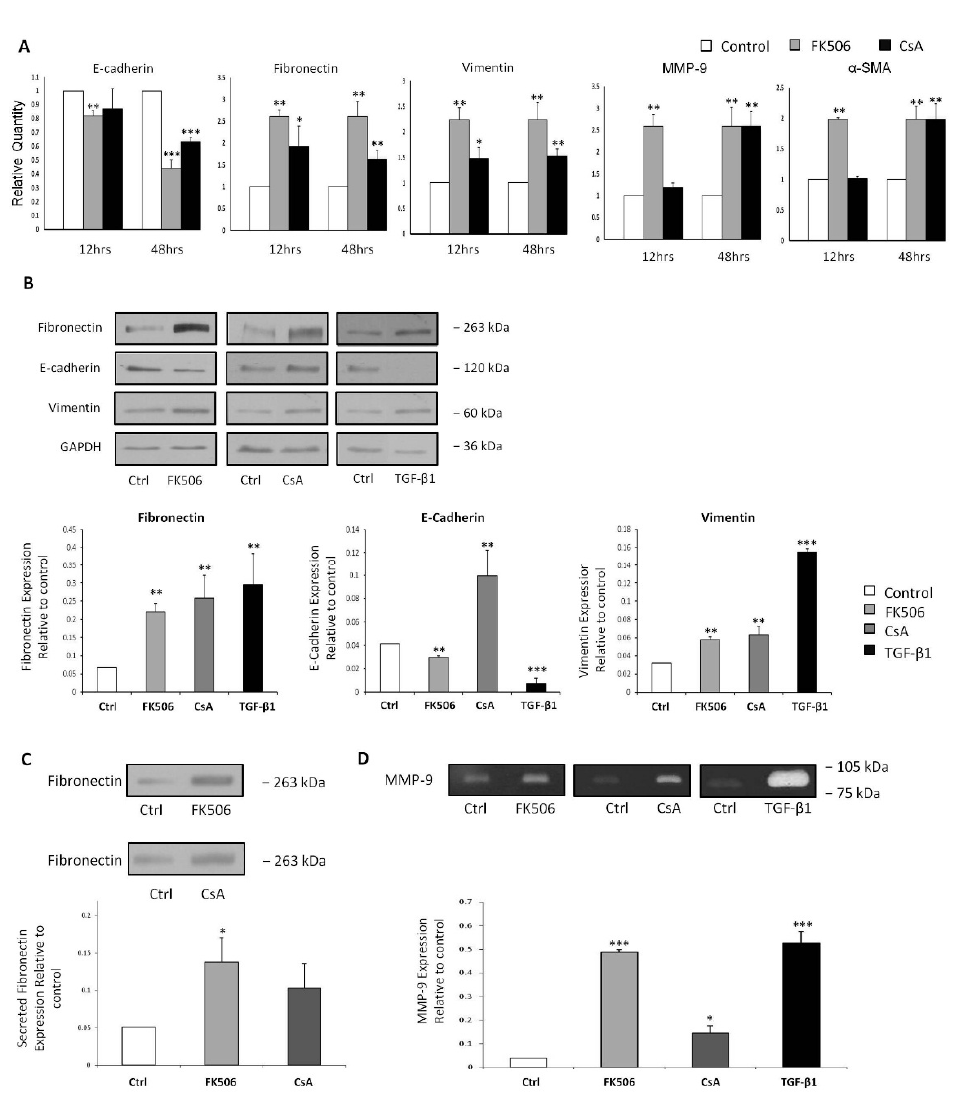
Figure 3. The effect of FK506 treatment on classical EMT markers. HK ‐ 2 RPTECs were cultured in 6 ‐ well plates and treated with control medium or medium containing 5 μ M FK506 or 5 μ M CsA for the indicated time periods. ( A ) RNA was isolated and cDNA synthesised. Real time RT ‐ PCR was then carried out on the cDNA using primers specific to E ‐ cadherin, fibronectin, vimentin, MMP ‐ 9 and α‐ SMA. 18S RNA was used as a total RNA control throughout. Data is expressed as a % change in mRNA levels relative to time ‐ matched control ± SEM ( n = 4): * p < 0.05, ** p < 0.01 vs. time ‐ matched vehicle treated control cells; ( B ) HK ‐ 2 cells were cultured on 6 ‐ well plates and treated with 5 μ M FK506, 5 μ M CsA or 5 ng/mL TGF ‐β 1 for 48 h and whole cell lysates were prepared. Equal amounts of protein were separated by SDS ‐ PAGE electrophoresis, transferred to nitrocellulose and indirectly probed for fibronectin, E ‐ cadherin and vimentin. GAPDH was used as a loading control. A representative blot is shown from three independent experiments; ( C ) HK ‐ 2 cells were cultured on 6 ‐ well plates and treated with 5 μ M FK506 or 5 μ M CsA for 48 h. Cell culture supernatants were harvested, centrifuged to remove cellular debris and concentrated using Amicon Ultra ‐ 4 Centrifugal Filter Devices (Millipore). Concentrated supernatants were separated by SDS ‐ PAGE electrophoresis, transferred to nitrocellulose and indirectly probed for fibronectin using a mAb and ECL detection system. A representative blot is shown from three independent experiments; ( D ) HK ‐ 2 cells were cultured on 6 ‐ well plates and treated with 5 μ M FK506, 5 μ M CsA or 5 ng/mL TGF ‐β 1 for 48 h. Cell culture supernatants were harvested, centrifuged to remove cellular debris and concentrated using Amicon Ultra ‐ 4 Centrifugal Filter Devices (Millipore). Gelatin substrate zymography was used to separate and assess MMP ‐ 9 activity. Clear areas represent areas of gelatinolytic activity. A representative zymogram is shown from three independent experiments.